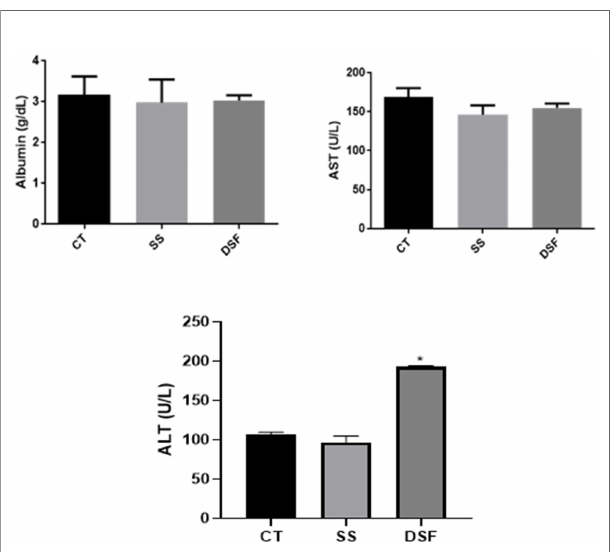
FIGURE 3 | Biochemical values obtained for the groups of mice studied (CT = control group; SS = treated with sterile saline and DSF = group treated with 1 ppm peracetic acid). The results are expressed as mean and standard deviation. *p <